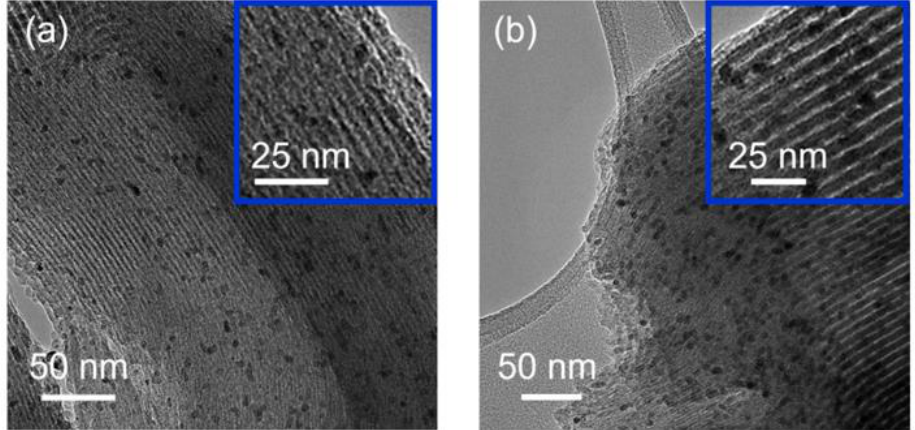
Figure 3. Representative TEM images of (a) Pd/SBA-15(low) and (b) Pd/SBA-15.